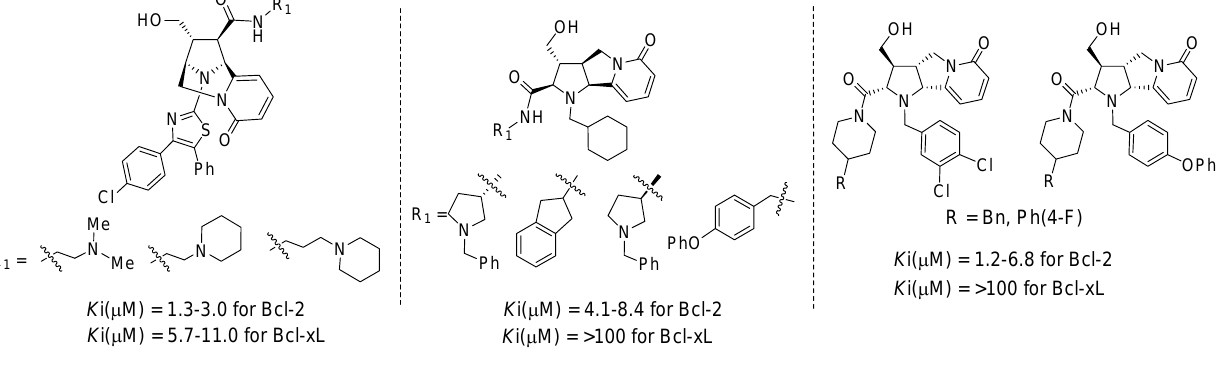
K i( μ M) = 1.3-3.0 for